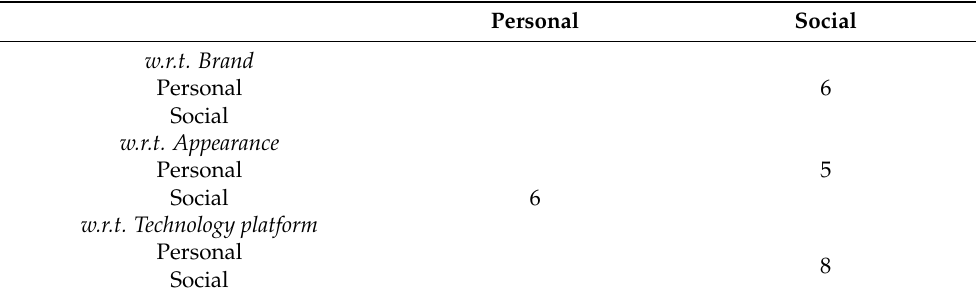
Table 5. Pairwise comparison matrix of PERSONAL and SOCIAL with respect to sub-criteria of CAR IDENTITY.